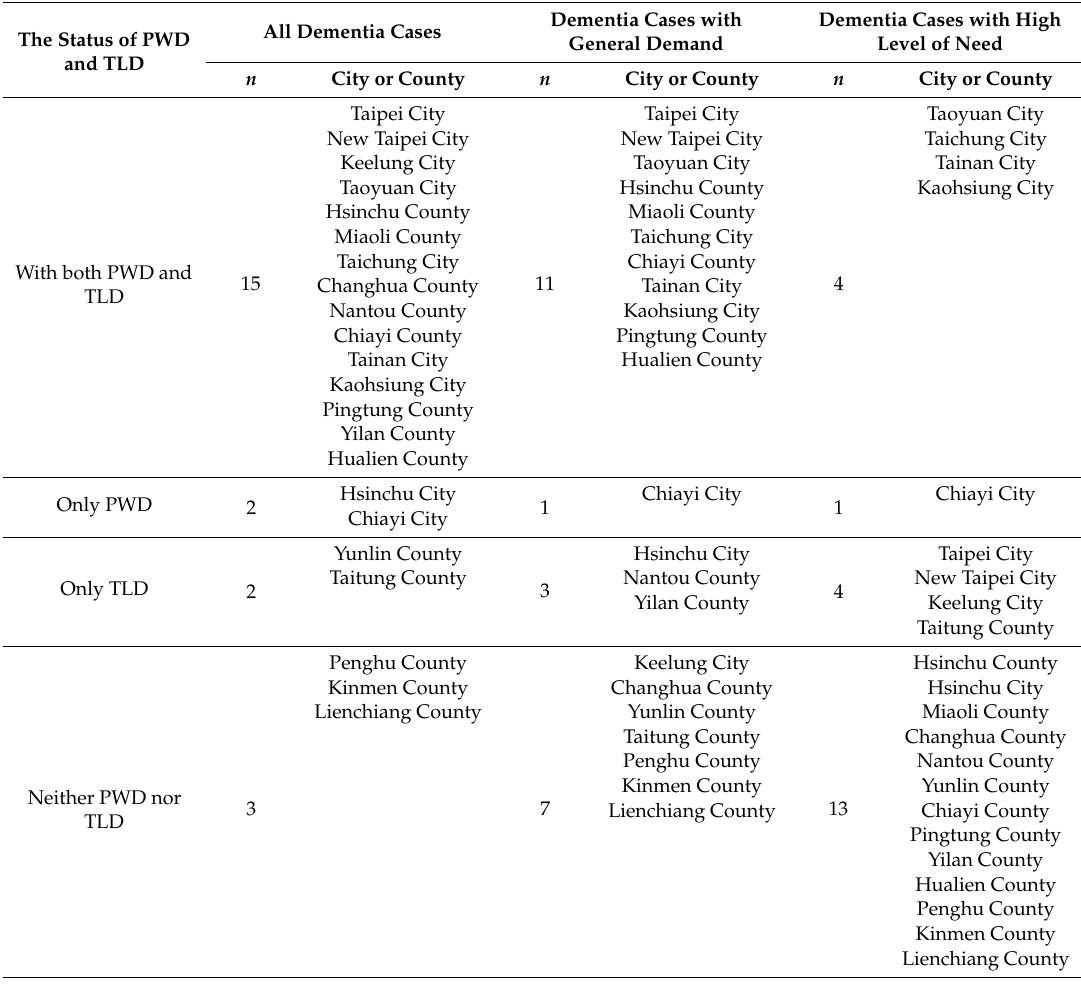
Table 5. A summary of the PWDs and TLDs grouped by the needs of dementia cases. The Status of PWD and